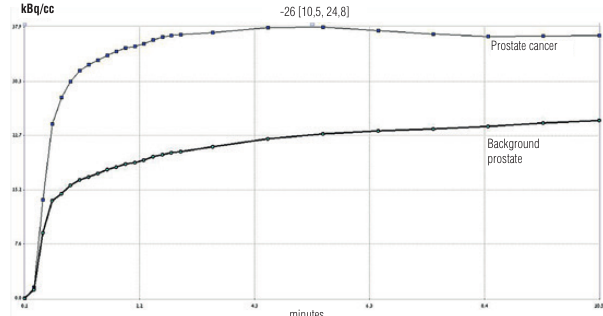
figure 2 - Linear fitted time-activity curves for prostate cancer (lighter line) and background prostate tissue (darker